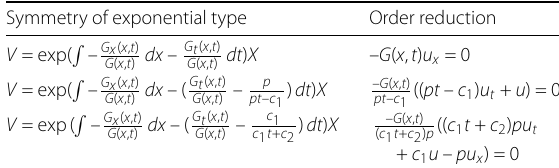
Table 7 Order reduction of Eq. (1) Symmetry of exponential type Order